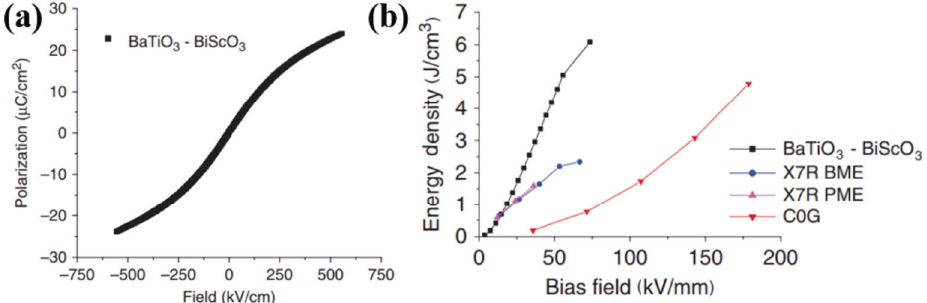
Fig. 26 (a) P – E loop and (b) energy density of BT–BS capacitors. Reproduced with permission from Ref. [25], © The American Ceramic Society 2009.